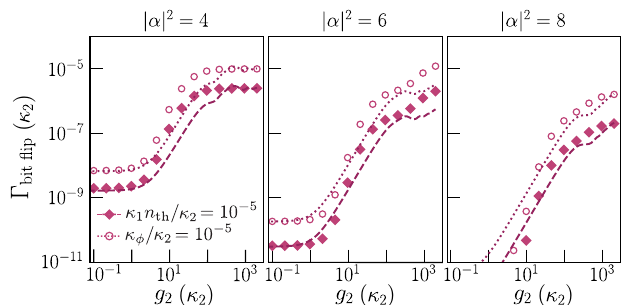
FIG. 6. Bit-flip error rate of an idle cat qubit confined by a combined TPE Hamiltonian and two-photon dissipation scheme for increasing cat sizes. Both axes are graduated in units of κ 2 . The cat qubit is subject to single-photon loss of amplitude κ 1 = 10 − 3 κ 2 , with additional thermal excitations κ 1 n th = 10 − 5 κ 2 (dia- monds, dashed lines) or pure dephasing κ φ = 10 − 5 κ 2 (circles, dotted lines). The exponential bit-flip suppression is restored at low enough g 2 , an order of magnitude earlier than for the Kerr Hamiltonian. Markers indicate numerical simulation data, lines FIG. 5. (a) Energy-level spacing between even and odd par- represent Eq. − E + in units ity eigenstates of the TPE Hamiltonian (cid:13) n = E − n n of g 2 . Dashed lines represent the threshold (cid:13) n = κ conf at differ- ent values of g 2 /κ 2 . Only eigenstates below this threshold benefit from the additional two-photon dissipation scheme, meaning that /κ (cid:8) 1 in Eq. (7). (b) Relative overlap between the n th (cid:13) conf n pair of excited TPE eigenstates and a cat-qubit state deformed by thermal or dephasing noise-induced leakage (cf. Appendix B). Dashed lines represent the threshold κ l (cid:14) n = κ l exp ( − c | α | 2 ) , which one may want to impose with certain values of c in order to achieve exponential suppression of bit-flip errors. All eigenstates above the threshold are susceptible to contribute to a bit-flip rate larger than the target rate via Eq. (7). (c) Individual terms of the sum of Eq. (7) with respect to time. The solid black line rep- resents the sum of all terms. The dashed black line represents p X ( t )/κ l t extracted from a numerical simulation of TPE con- finement with single-photon loss κ 1 = 10 − 3 g 2 and thermal noise n th = 10 − 2 .